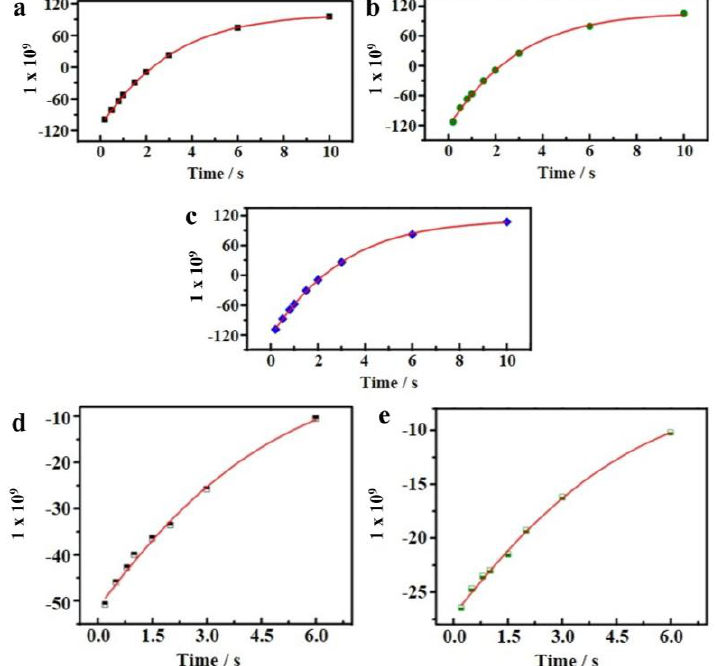
Figure 3. NMR T 1 represents the time required for the longitudinal component of magnetization to recover its equilibrium value after applying a perturbing pulse sequence. Spectra ( a – e ) represent plus of spectral signals as a function of repetition time for DI water, AuNT (light-free) water, sAuNT water, D 2 O, and sAuNT D 2 O